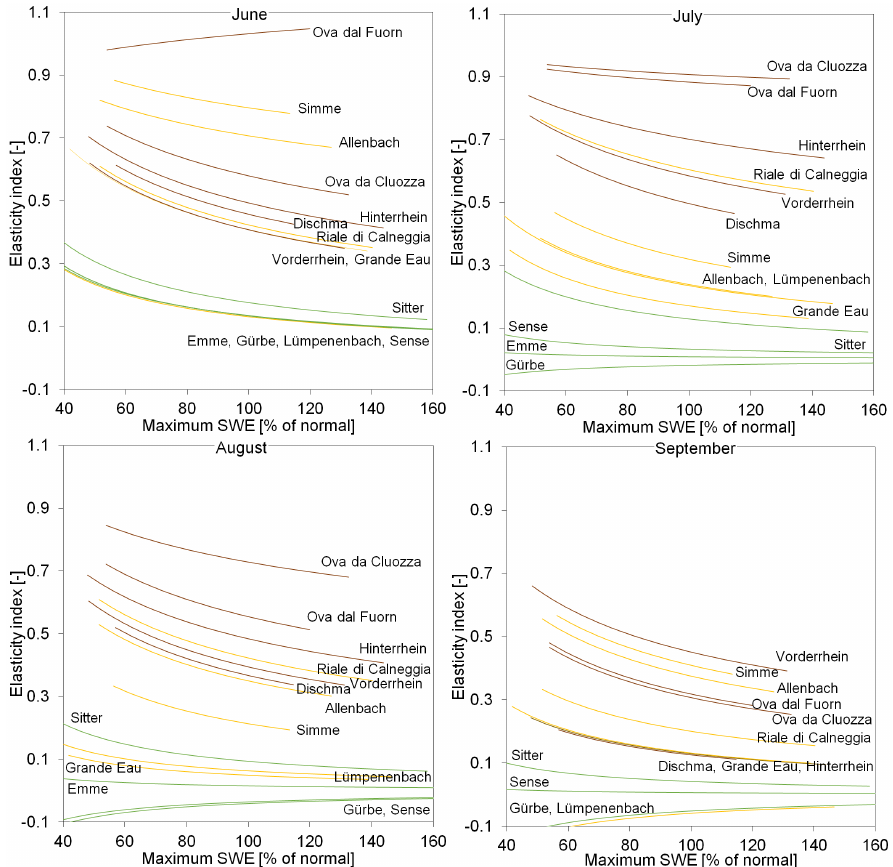
Figure 6. Elasticity index showing the sensitivity of minimum discharge to changes in SWE. The index was calculated from the 50% probability of prediction. Line colours indicate the catchment group according to mean elevation (dark brown: > 2000ma.s.l.; light